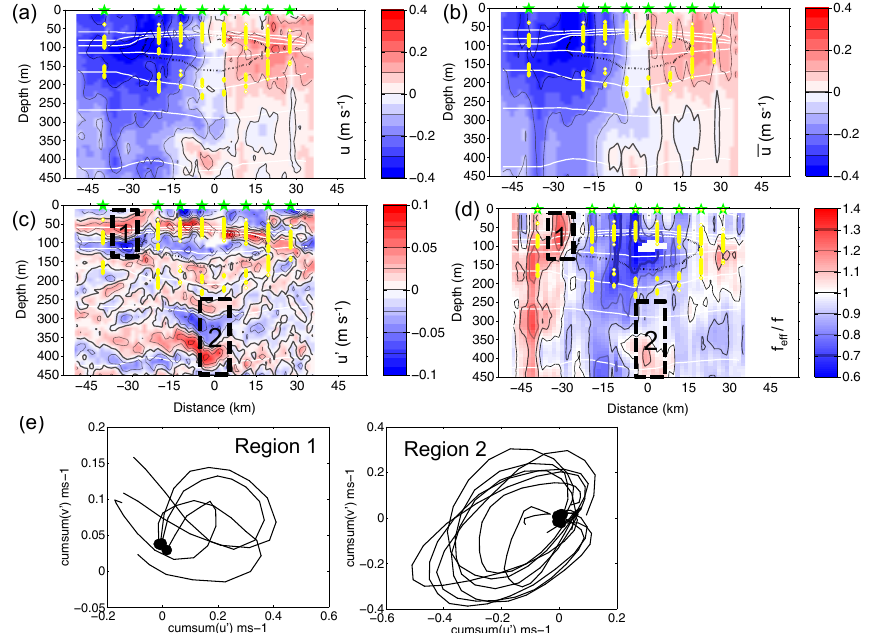
Figure 5. (a) Observed zonal velocity, (b) boxcar filtered zonal velocity (applied over 120m), and the (c) difference between observed and boxcar filtered velocities. The thick black broken line indicates the 40µmolkg − 1 oxygen concentration; white contours are selected density anomaly contours ( (cid:49)σ = 0 . 2kgm − 3 ) determined by gridding CTD profile data (see the green stars at 0dbar for station positions). The yellow dots indicate the N 2 maximum from CTD profile data. (d) Ratio between the effective Coriolis parameter ( f eff ) and local Coriolis parameter (f) . (e) Progressive vector diagram of u (cid:48) /v (cid:48) for regions 1 (250 to 450m depth, seven profiles) and 2 (20 to 140m; three profiles) (see c and d for locations); the black dots mark the shallowest